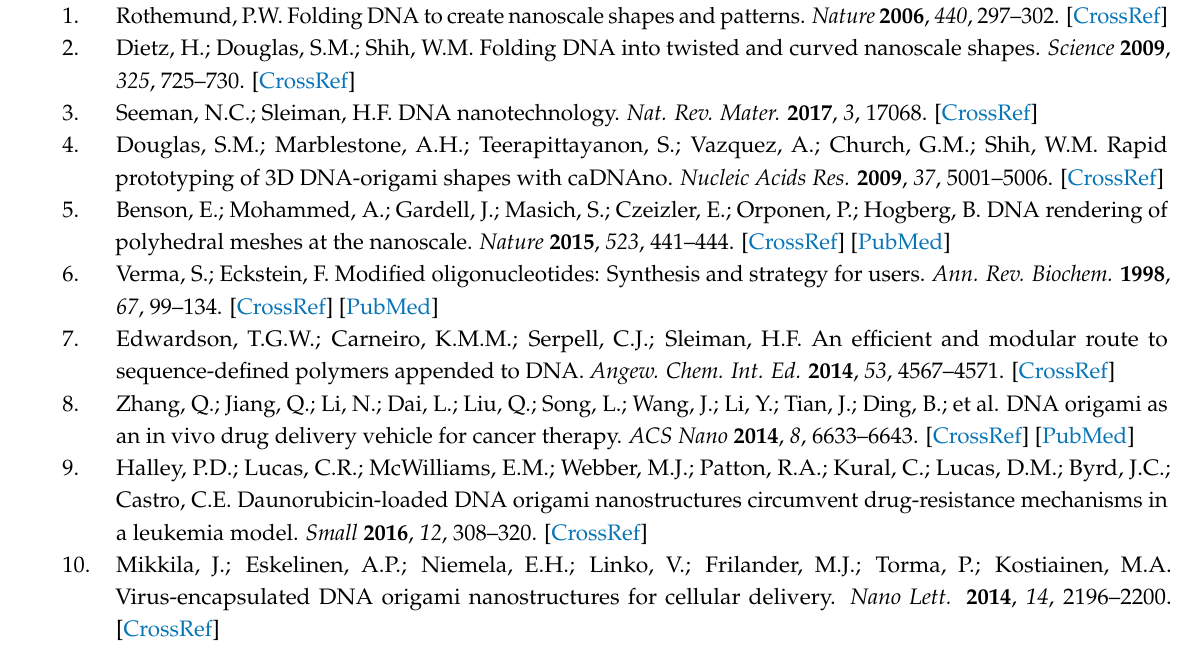
Figure S1: 2D maps and Figure S2: graphical representation of constructs, Table S1: DNA sequences and Table S2: DNA strand